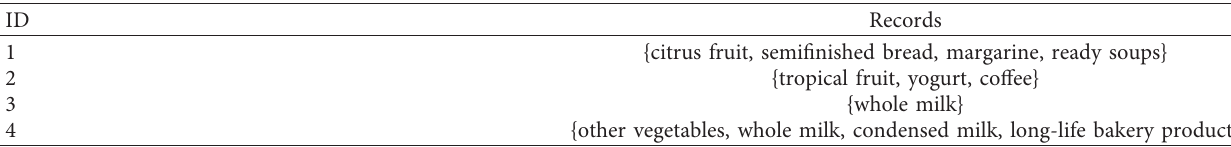
Table 2: The data format of the Groceries dataset.